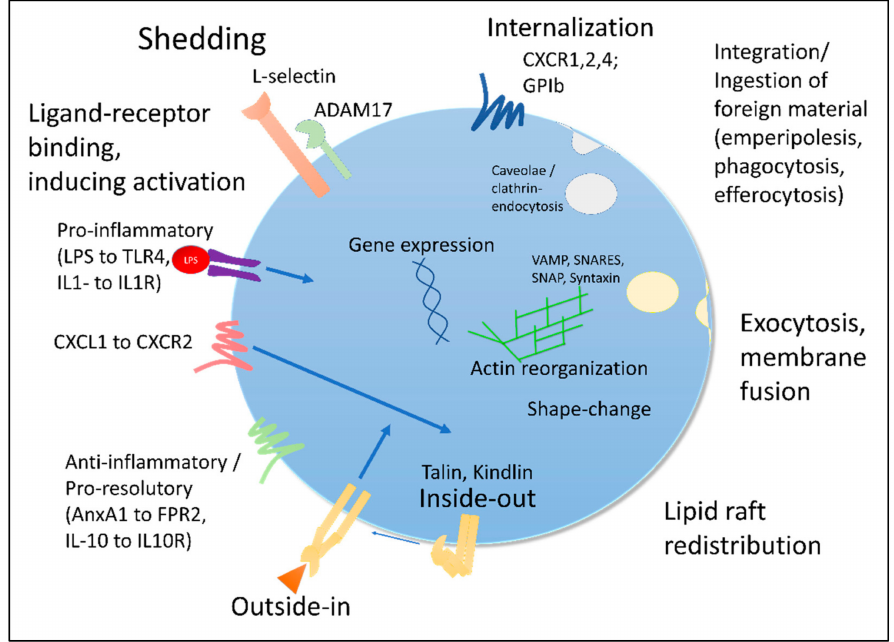
Figure 1. Modes of cell phenotype switches. Immune cells are activated by ligand–receptor binding. This may evoke different responses, including shedding or internalization of surface molecules, exocy- tosis and vesicle–membrane fusion, integrin activation, lipid raft redistribution, actin reorganization and shape-changes and potentially the integration or ingestion of foreign